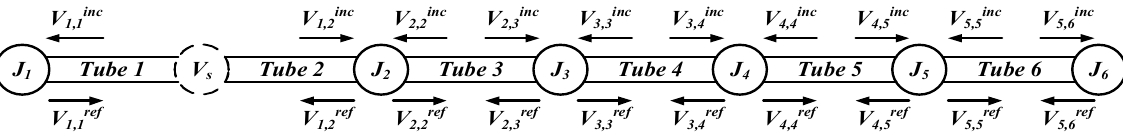
Figure 2. Equivalent circuit of an irregular shielded cavity irradiated by the plane waves.